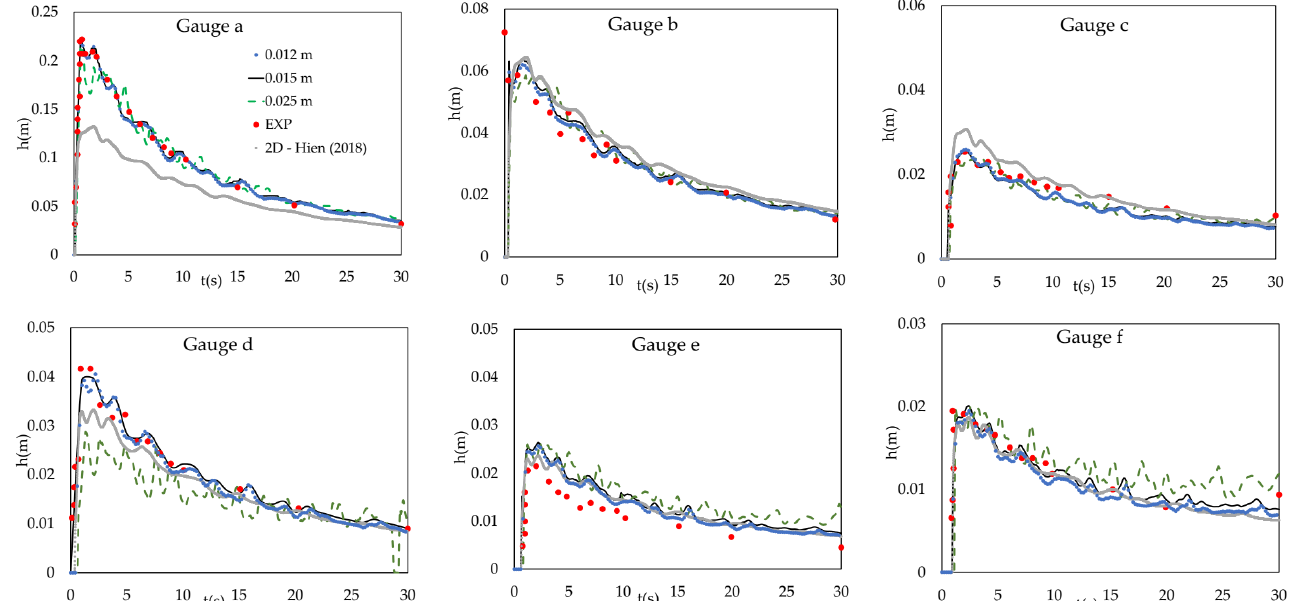
Figure 2. Water depth profiles at different gauges.